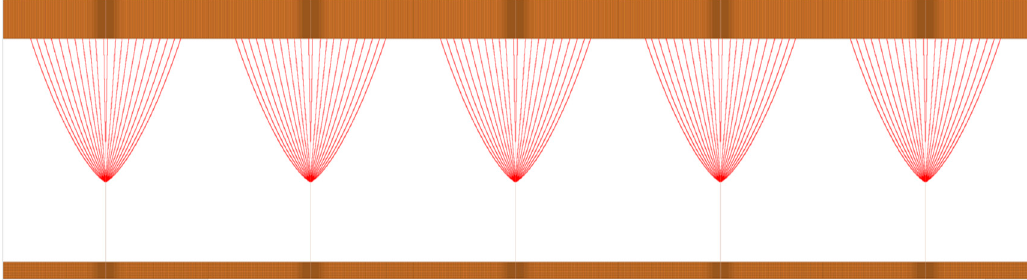
Figure 5. Electron beam trajectory of the field emission from a graphite sheet array ( s / l = 4, U = 200 V, and d = 2.75 μ m).